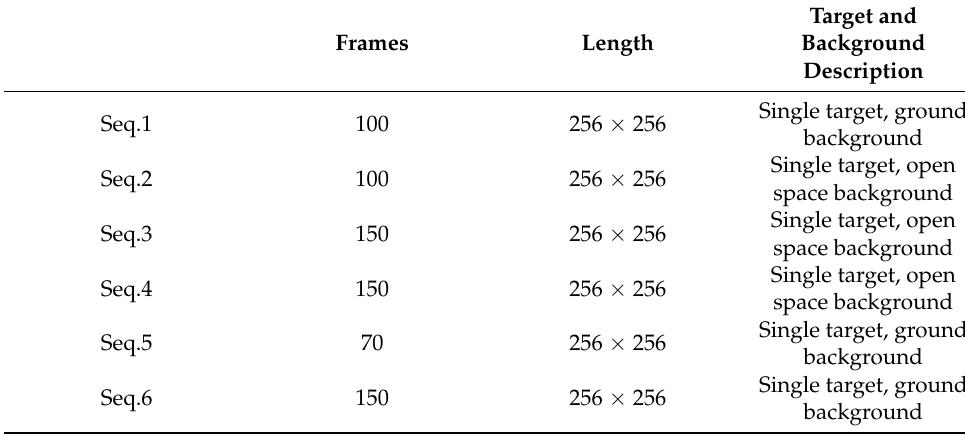
Table 2. Sequence information for six different scenes.